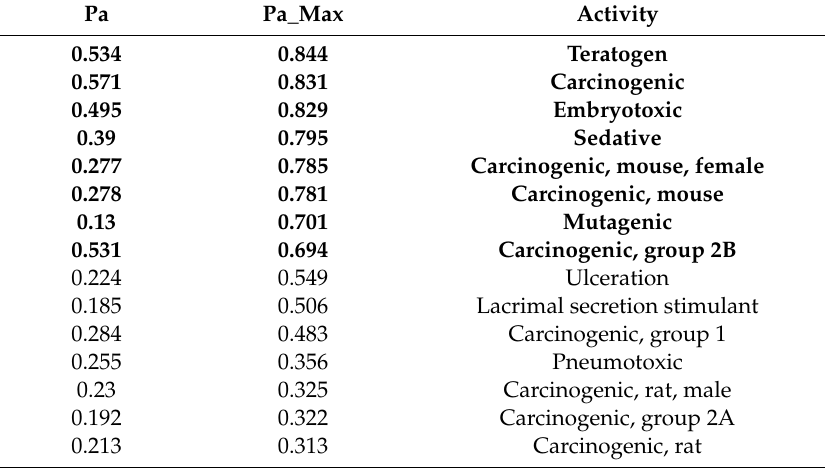
Table 1. Toxic and adverse e ff ects predicted for Phenytoin (Pa) and the highest Pa_max estimates for its